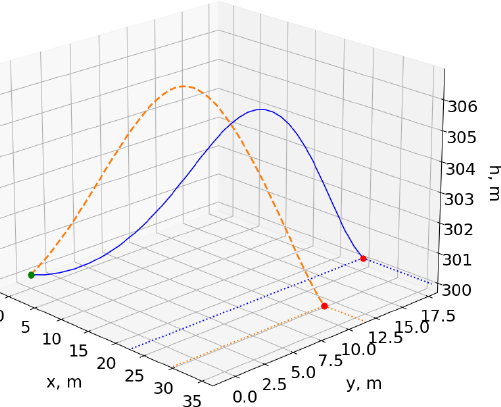
Figure 17. NEAT and TO simulated trajectories of the dynamic soaring SUAV. Neurocontroller in solid, optimized trajectory in dotted.